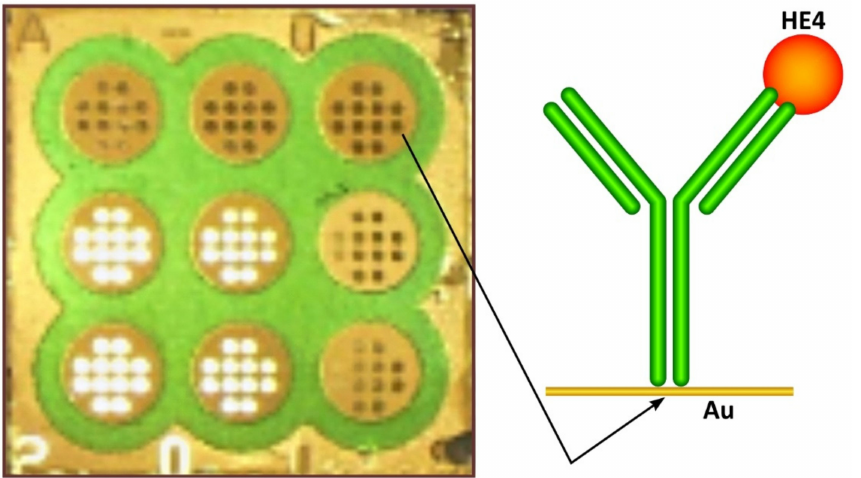
Figure 1. Chip architecture and sketch of